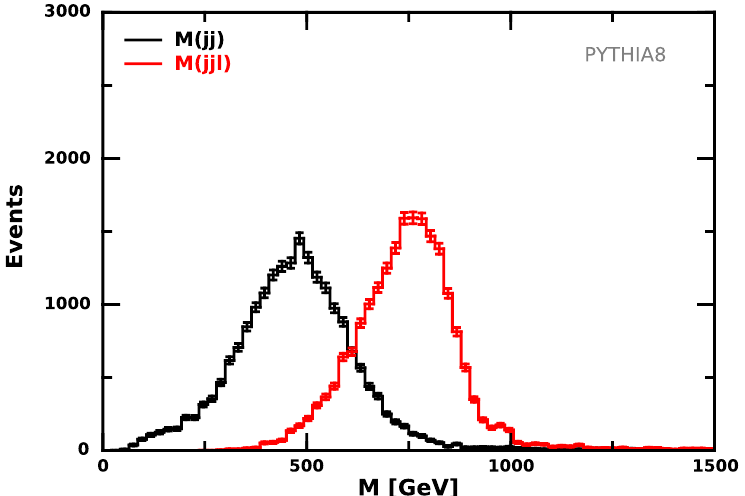
Figure 7. The invariant masses of two jets ( m jj ) and two jets and a lepton ( m jjl ) in events A → B C simulated with PYTHIA 8 with the settings described in the